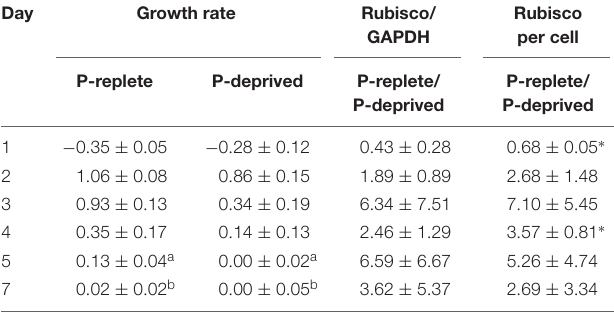
TABLE 1 | Specific growth rates ( µ , day − 1 ) and comparison (ratios) of Rubisco abundance (normalized to GAPDH and per cell) between P-replete and P-deprived conditions in the 7-day experimental period (mean ± standard deviation). Day Growth rate Rubisco/